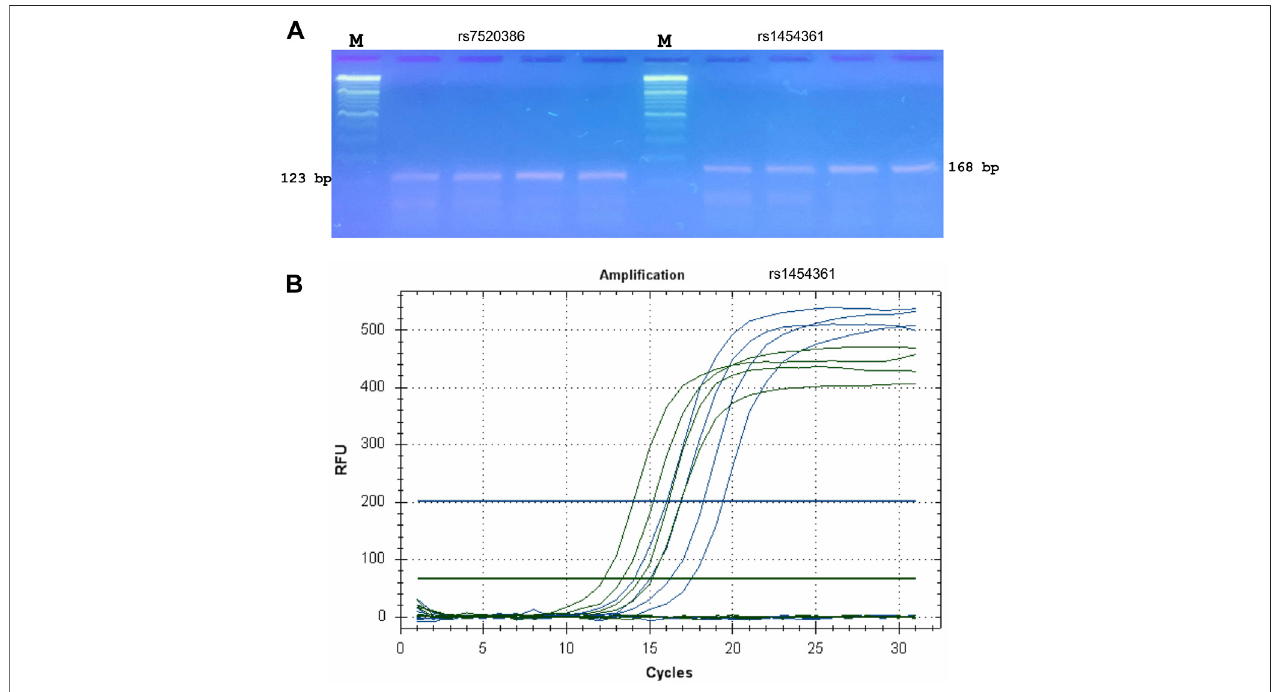
FIGURE 3 | Validation and testing of ASQ method. Probes for ASQ assays were designed using FastPCR to human SNPs (rs7520386 and rs1454361) that were employed for SNP genotyping of humans in forensic studies and PCR products from a series of PCR reactions using these primers were examined by the agarose gel electrophoresis was used without staining (A) . M — Thermo Scienti fi c GeneRuler DNA Ladder Mix (100 – 10,000 bp) stained with SYBR Green I. Primer sequences are displayed in Supplementary Table S1 . PCR bands of the correct size (123 bp for rs7520386 and 168 bp for rs1454361, respectively) were obtained from each qPCR. (B) qPCR ampli fi cation plot for SNP (rs1454361). FAM plot (green) shows ampli fi cations of a A-allele, whereas HEX plot (blue) shows ampli fi cations of a